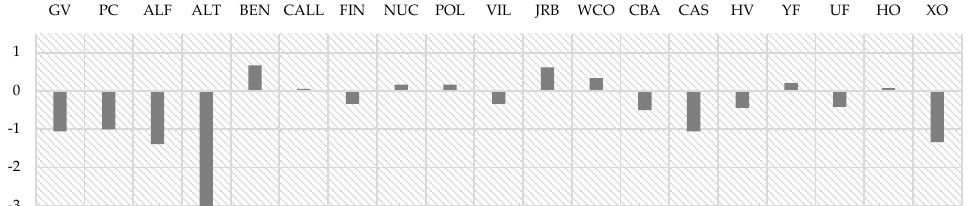
Representation vs. Power: Under-over values